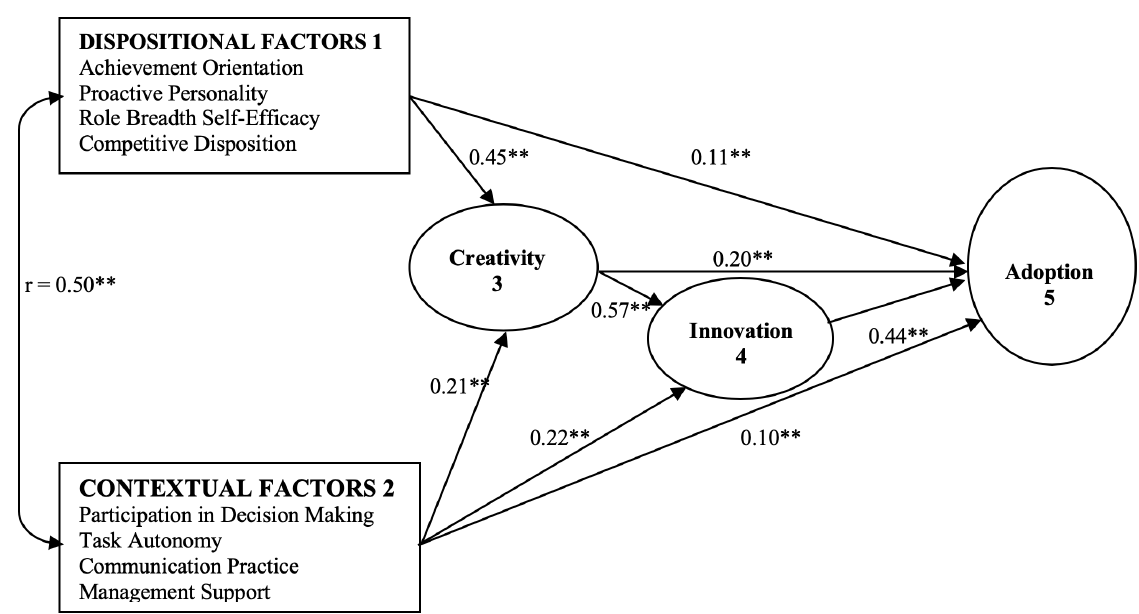
Fig. 3. Revised model of employee innovation process showing the phases and their antecedent fac-